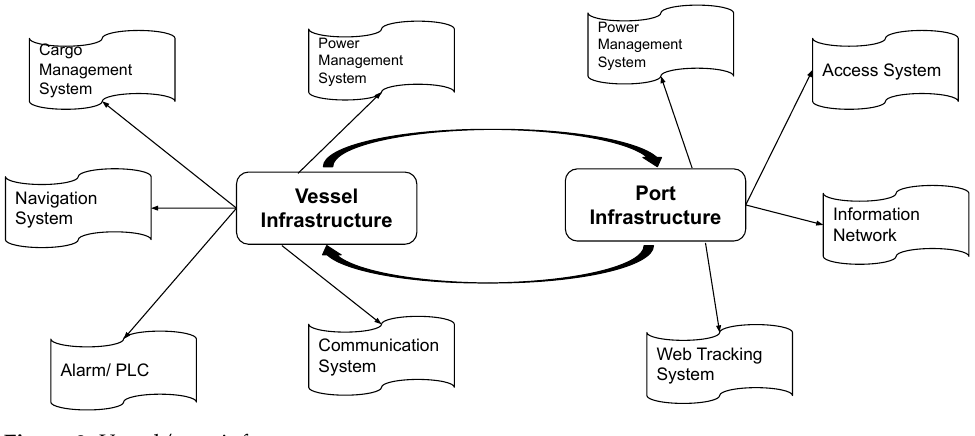
Figure 3. Vessel/port